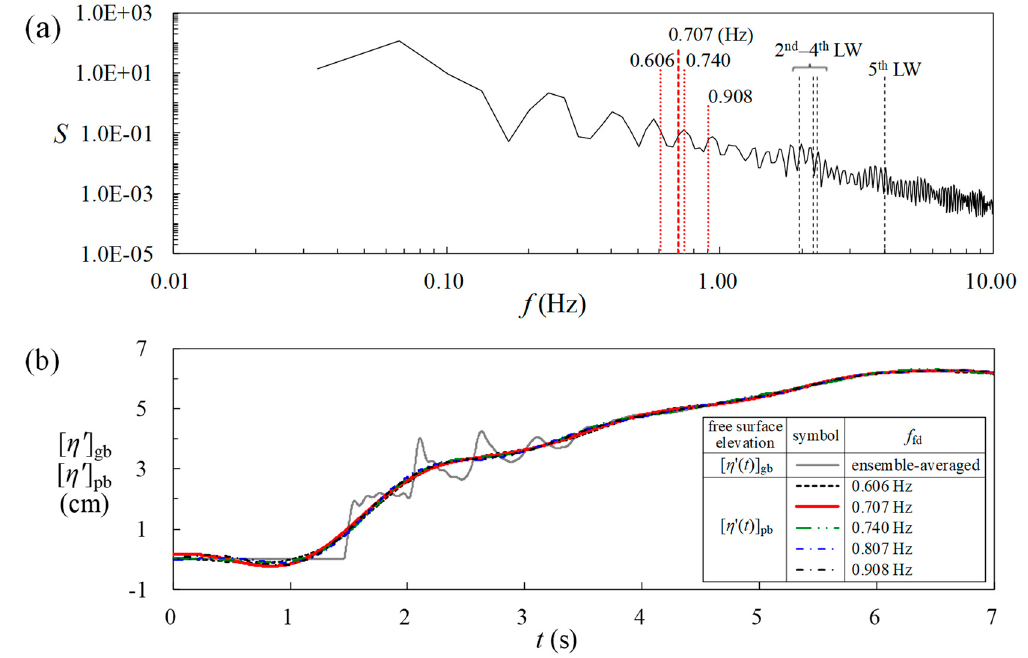
Figure A1. ( a ) Power spectrum S ( f ) of free surface elevation [ η ′ ( t )] gb measured at SMS; ( b ) obtaining free surface elevation of pure bore [ η ′ ( t )] pb from counterpart of pure bore [ η ′ ( t )] gb using inverse fast Fourier transform (IFFT) with five different values of f fd .